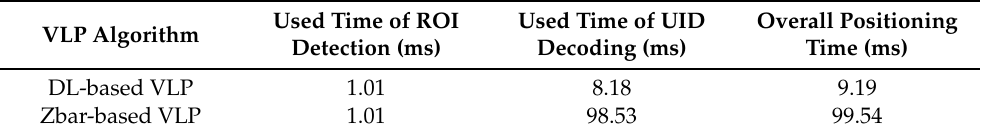
Table 3. The time of the proposed DL-based robust VLP